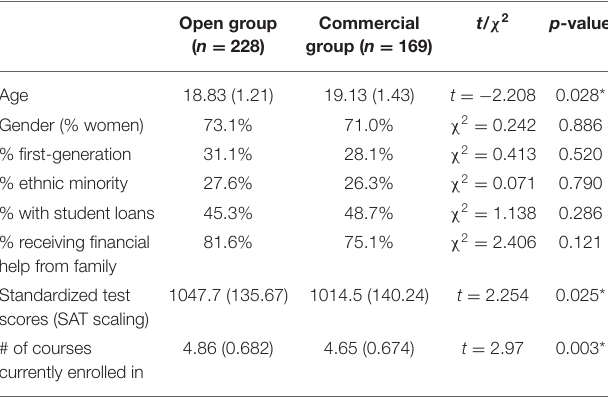
TABLE 1 | Sample characteristics by textbook